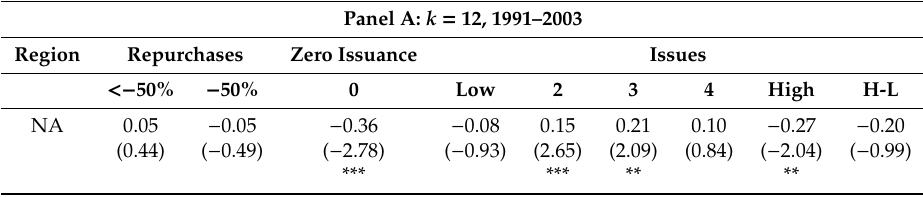
Table 14. Univariate Sorts by Net Share Issues—Subperiod and Size Analysis. This table presents results identical to Table 13 but using di ff erent subsamples. Results in Panel A are based on data over the subperiod 1991–2003 for k = 12. Results in Panel B rely on the data over the subperiod 2004–2016 for k = 12. Panels C and D subdivide the sample into big stocks and small stocks, respectively. Big stocks have the largest market capitalization comprising 90% of the total market capitalization. *** / ** / * indicates significance at the 1, 5, and 10% level,